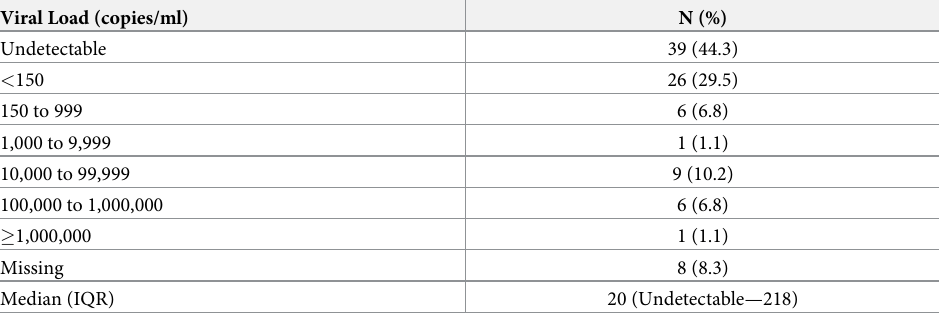
Table 2. Baseline viral load in 1,296 people living with HIV (PLHIV) with asymptomatic Leishmania infection (ALI) in Bihar,